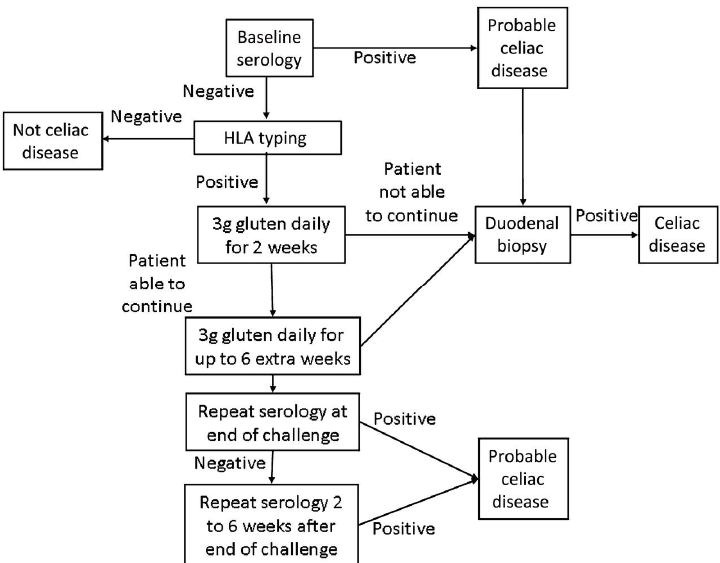
Figure 3. Modified Gluten Challenge Algorithm [68]; Reproduced with permission from Leffler D.A. and Kelly C.P. (Kinetics of the histological, serological and symptomatic responses to gluten challenge in adults with coeliac disease. Gut 2012